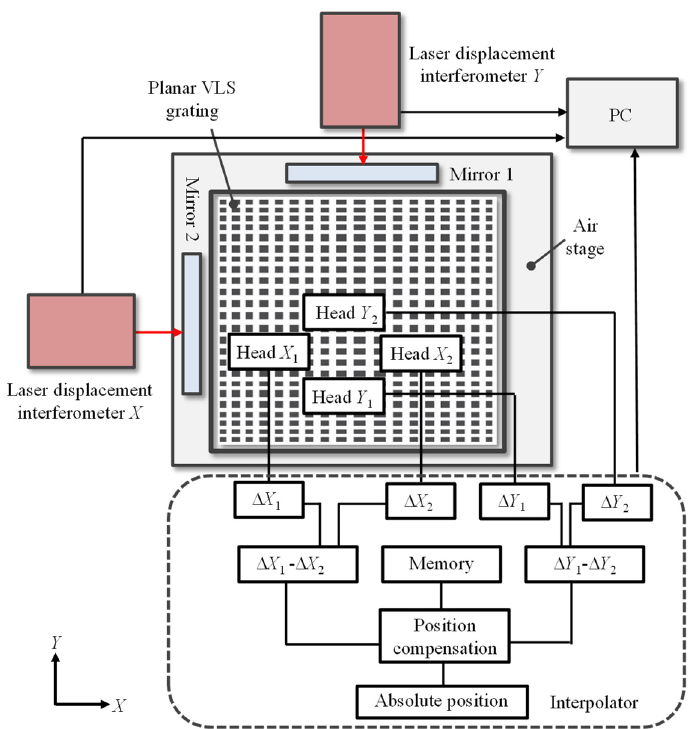
Figure 17. The experimental setup for the evaluation of the reading errors of the optical head in the absolute planar encoder.